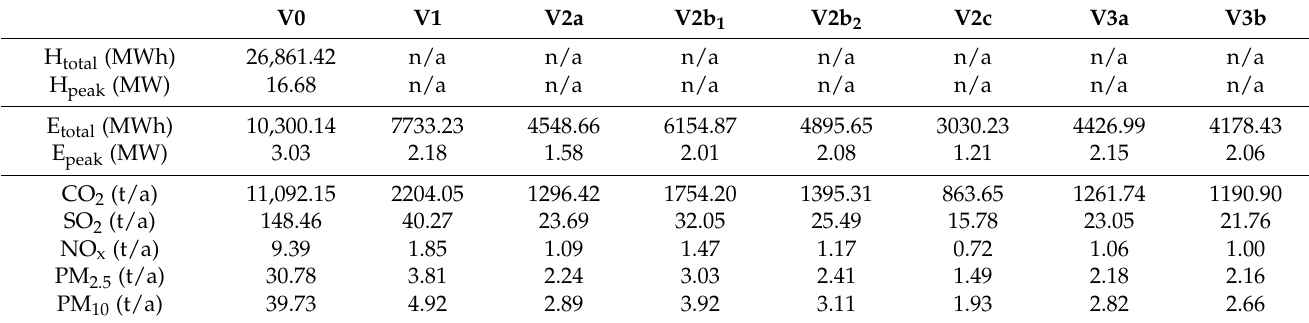
Table 4. Energy- and environmental-related summary for the Nowosolna cluster.